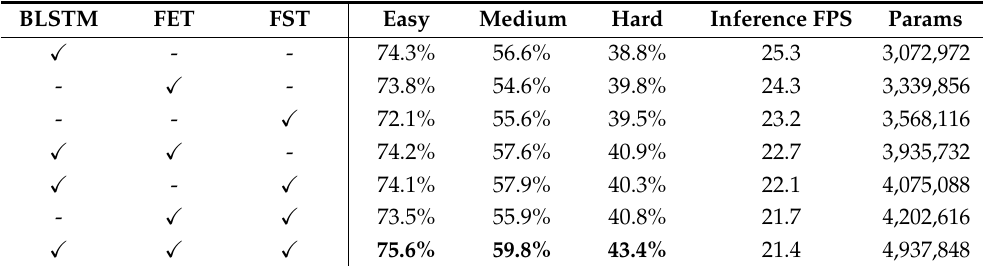
Table 1. Ablation study on each module. The comparison results on the accuracy of ASTER with and without each module in the backbone are shown. “Inference FPS” means the number of frames the ASTER can process per second with the proposed model as preprocessing, and “Params” means the total number of network